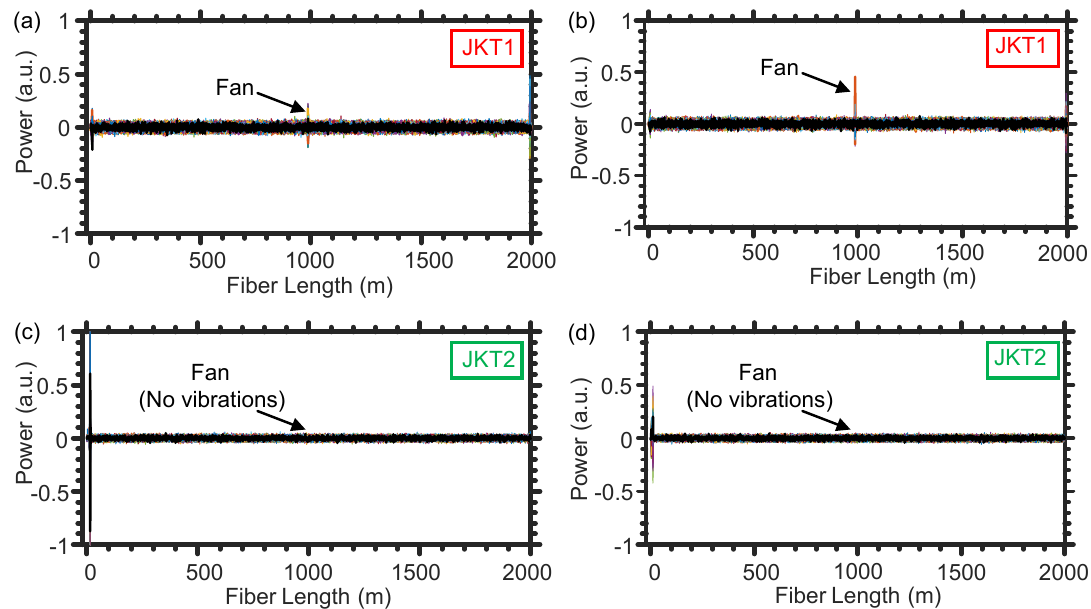
Figure 6. Representative examples of the temporal vibrations caused by the wind when using the SMF of JKT1 ( a , b ) and JKT2 ( c , d